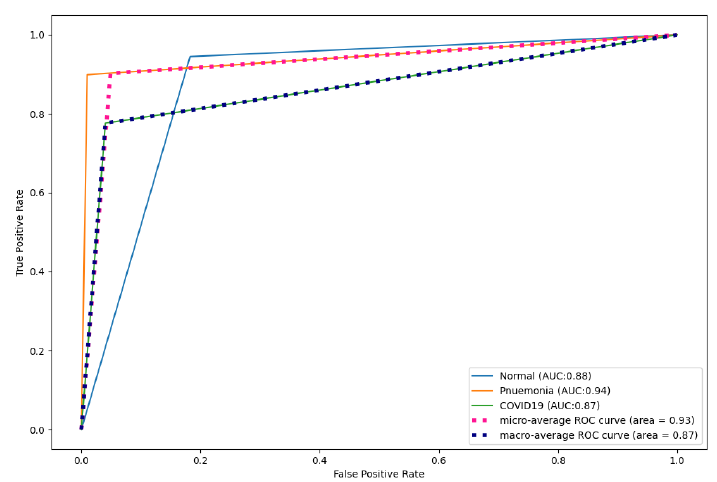
Figure 18. DesNet121 ROC curves for X-ray images.